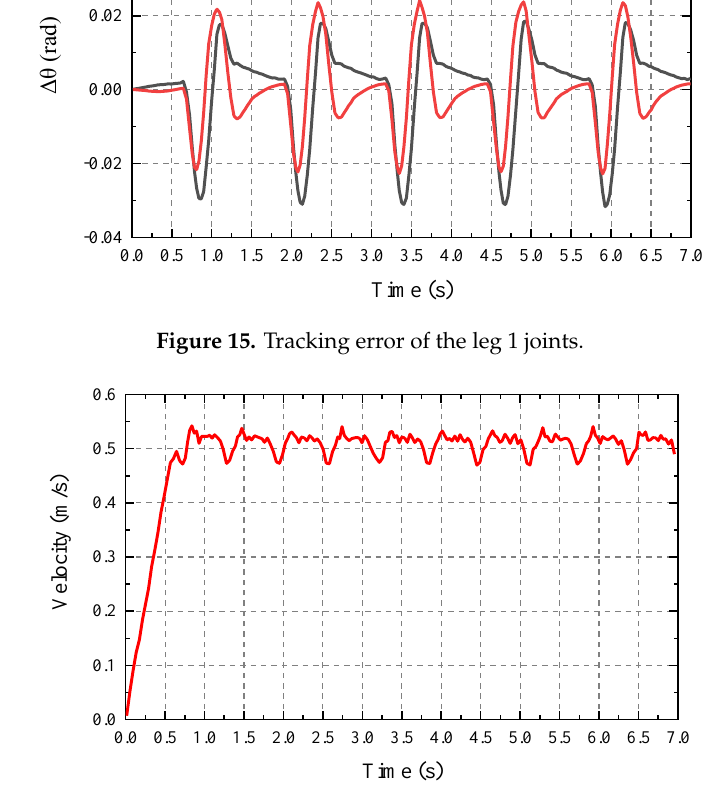
Figure 17. The cylinder pressure of leg 1. Figure 18. The total flow rate of the HHR. 6. Conclusions This paper presents the mechanical design and gait optimization of the hydraulic hexapod robot based on energy conservation. It aims to address the problem of building up a framework for the modeling of the hydraulic walking robot and provides an effective design process based on the proposed framework. A two-stage process was adopted for modeling and optimizing the structural and gait parameters of the HHR. In the modeling stage, a step-by-step study is introduced to build geometric, kinematic, static, foot trajectory, and hydraulic driving system models. By establishing the above model, it is possible to predict the walking state and energy consumption of the robot. The